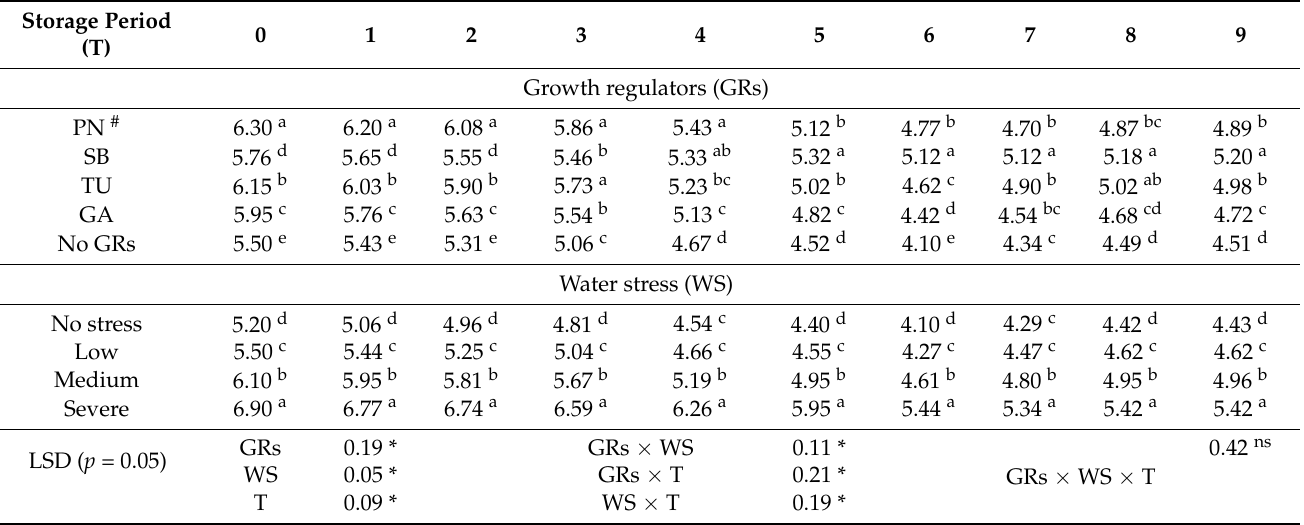
Table 2. Influence of different GRs and water stress levels on rehydration ratio (RR) of onion during 9 months of storage